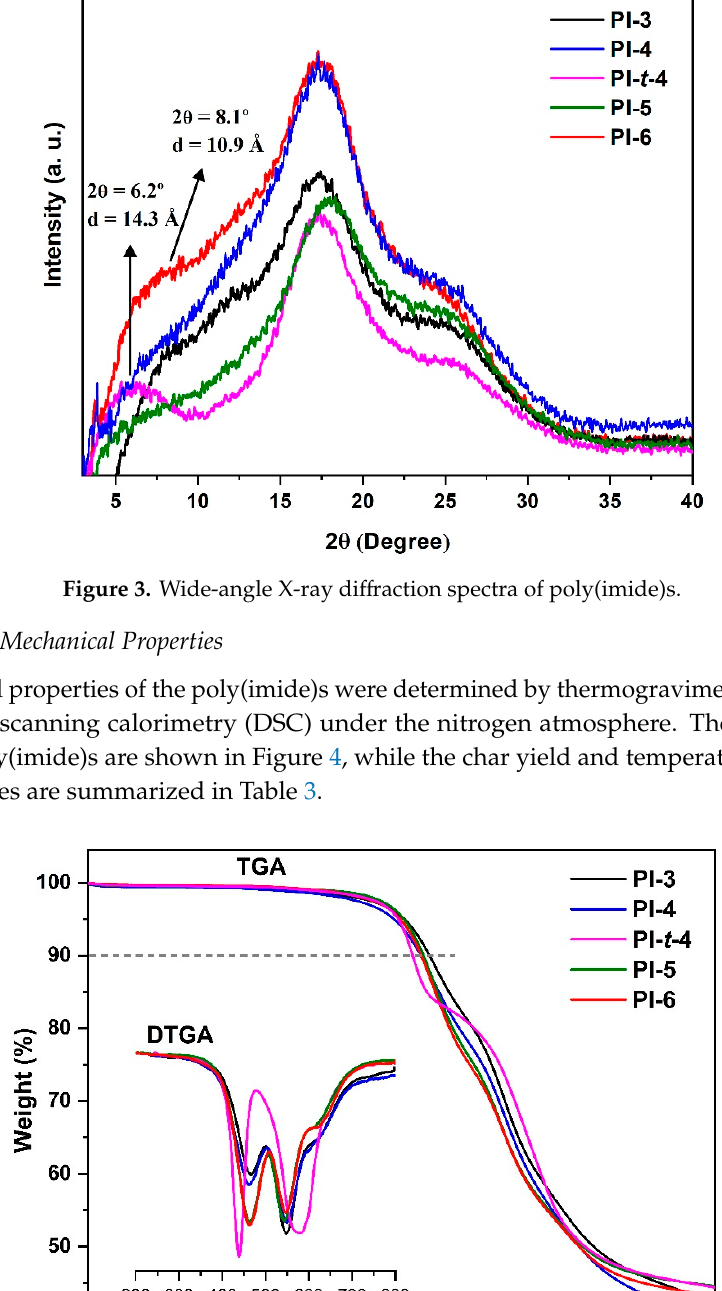
Table 3. Thermal properties of poly(imide)s.